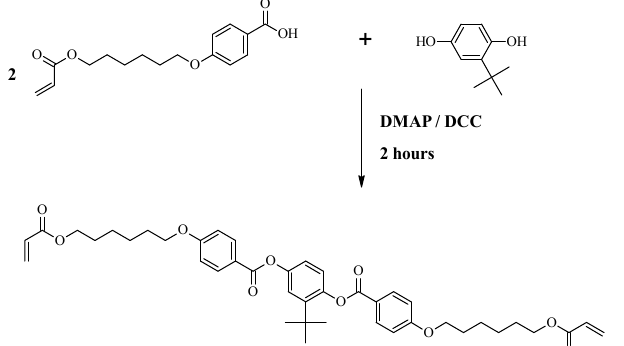
Figure 1. Synthesis of the nematic monomer 2- t -butyl-1,4-phenylene bis (4-(6-(acryloyloxy)hexyloxy)benzoate) (tBC6DA).